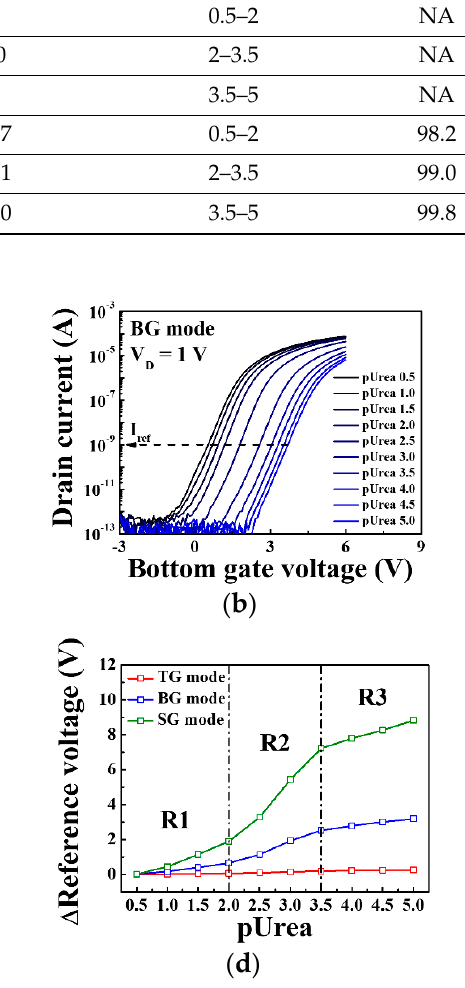
platform in the ( a ) TG, ( b ) BG, and ( c ) SG modes for various urea concentrations. ( d ) Change in the reference voltage of